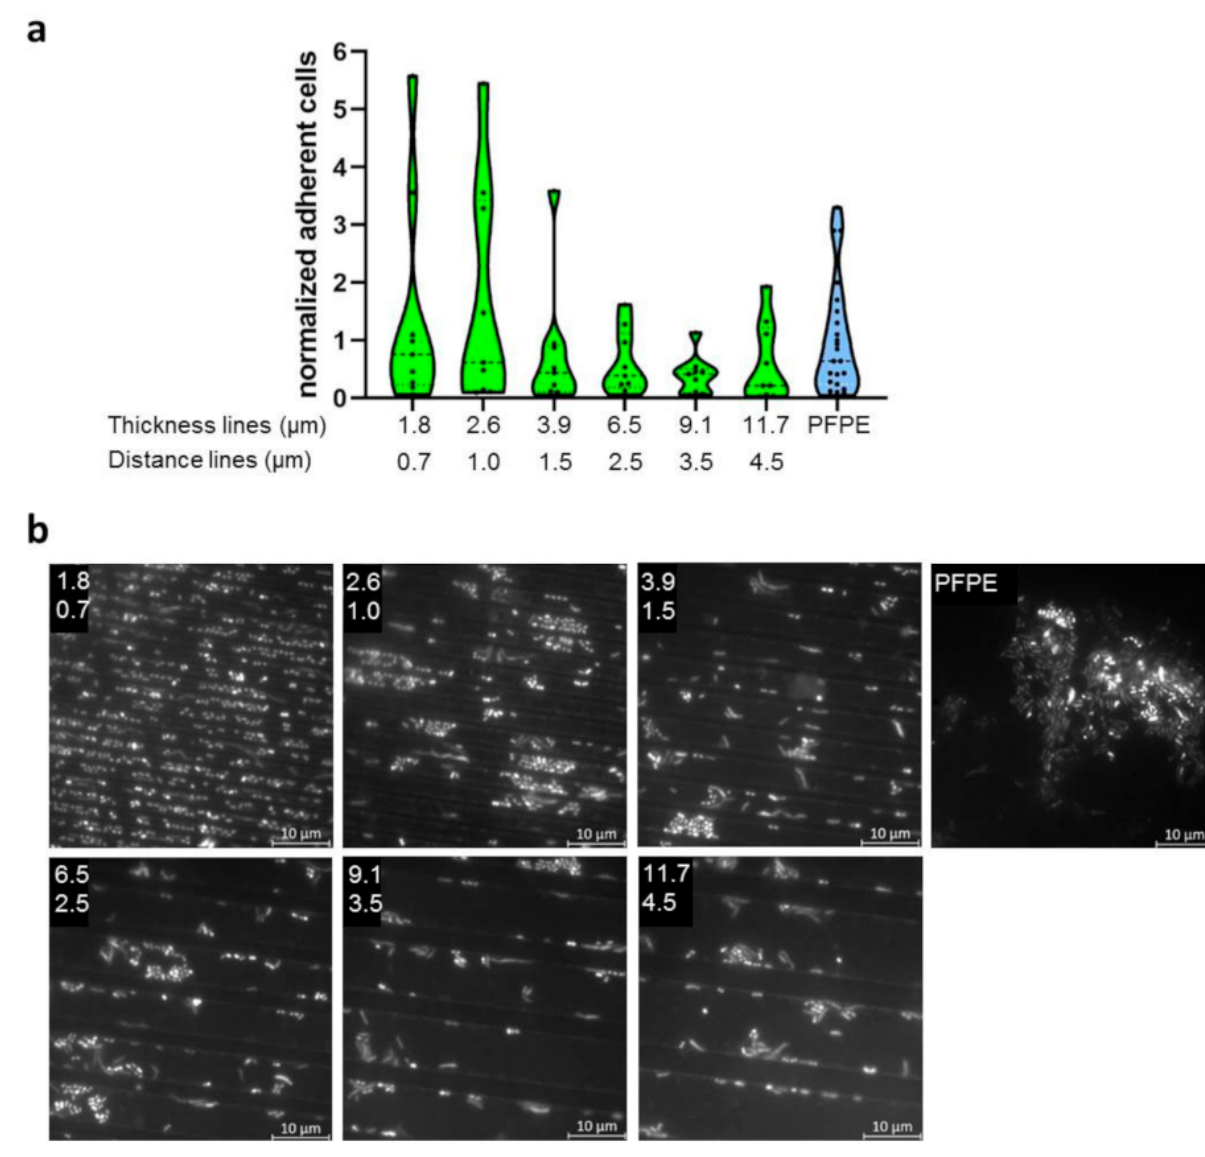
Figure 3. Adherence of microorganisms to specimens with line structures of different dimensions. ( a ) Specimens made from PFPE containing linear structures of different dimensions were exposed to the oral cavity for 8 h. Here, only selected dimensions are shown, with the full dataset available in Supplementary Figures S3 and S6. Depicted is the number of adherent cells normalized to the adherence on plain PFPE. ( b ) Representative images of DAPI-stained specimens for the analyzed dimensions. The upper number indicates the thickness of the lines in µ m and the lower number the distance of the lines in µ m. Microorganisms are mostly detected within the recessed linear